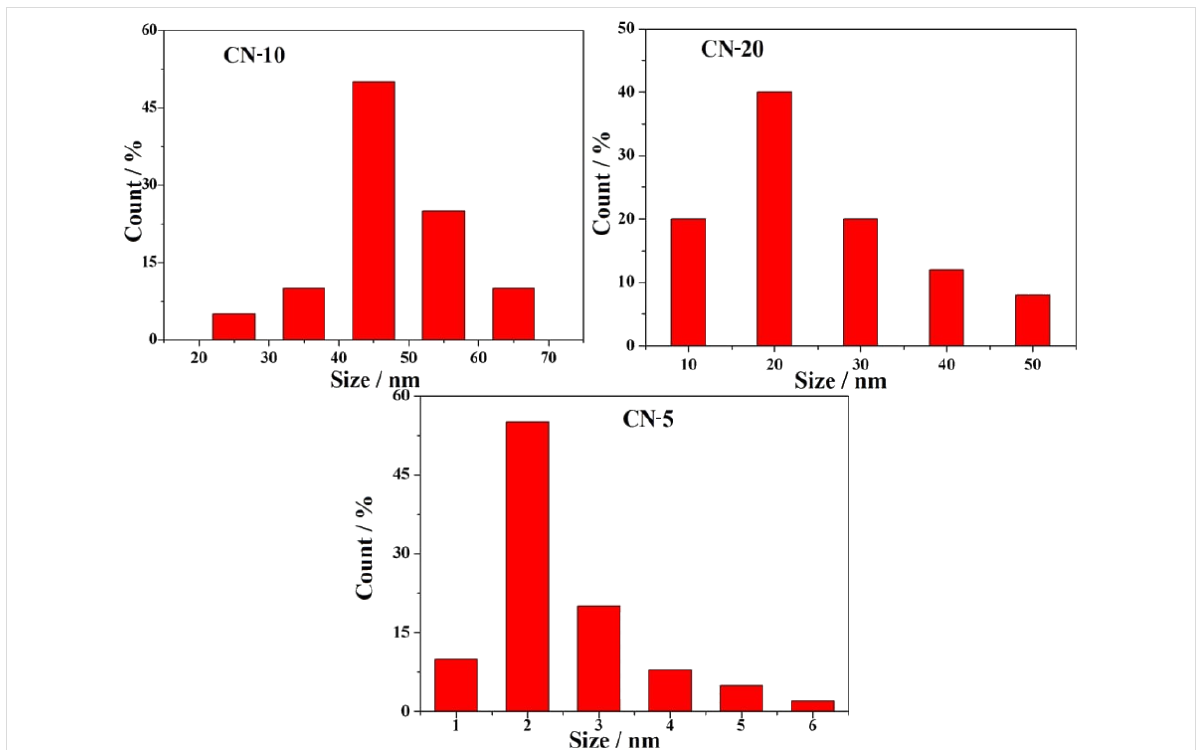
Figure 6: Particle size distribution of the synthesized CN nanoflakes and quantum dots.